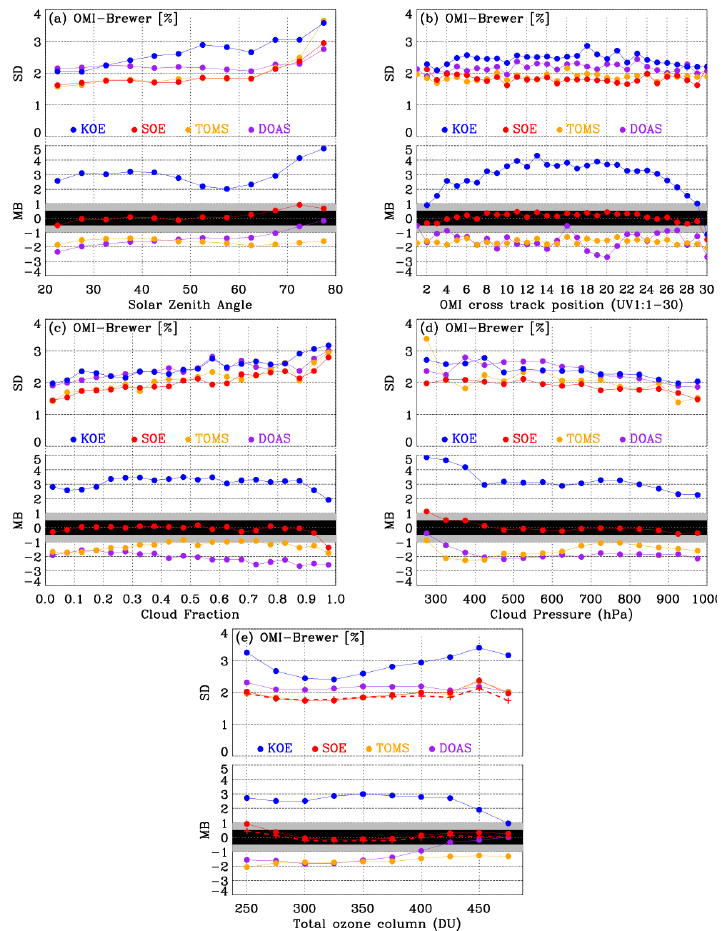
Figure 5. Dependence of OMI–Brewer relative mean differences and 1 σ standard deviations on (a) OMI solar zenith angle, (b) OMI cross- track position (UV1-based), (c) effective cloud fraction, (d) effective cloud-top pressure, and (e) total ozone column. The calculations for (c) and (d) are done for correlated data sets with OMI solar zenith angle <45 ◦ , in order to enhance the effect of cloud parameters on OMI retrievals. The red dashed line in (e) represents the SOE comparison with the use of the tropopause-dependent climatology presented in Bak et al.